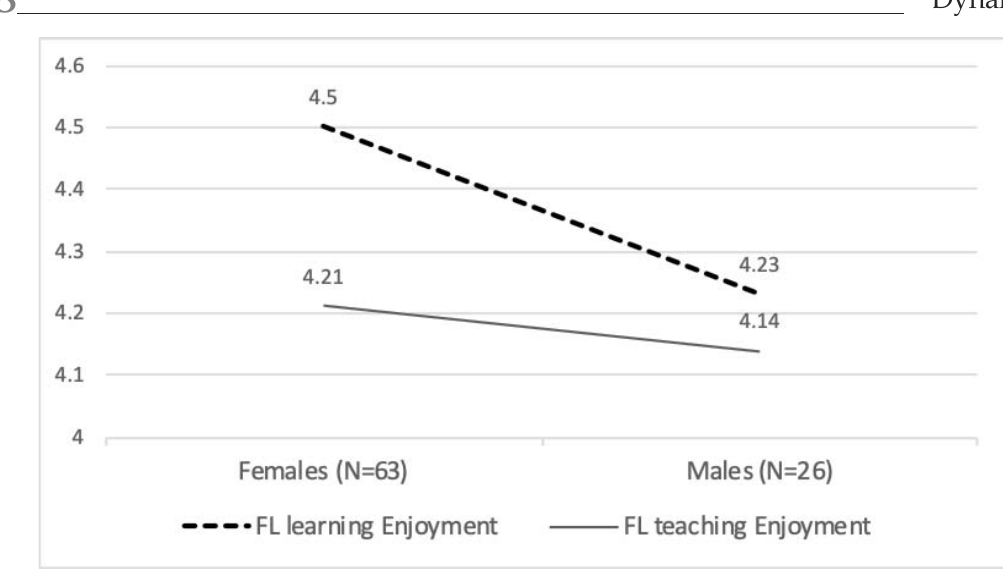
Figure 1. FL learning Enjoyment and FL teaching Enjoyment form males and females.